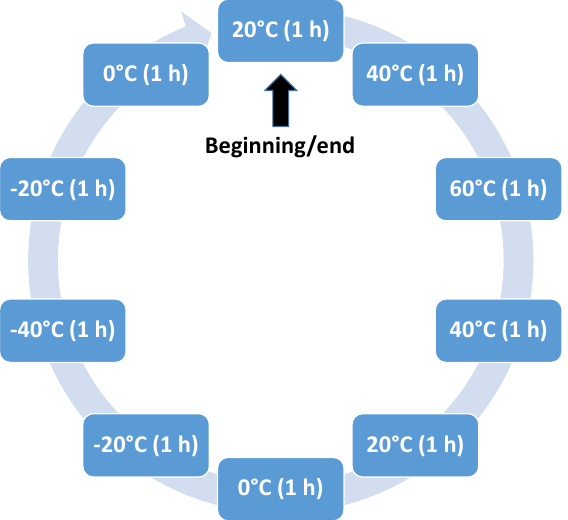
Figure 13. Description of the thermal cycle performed on TiO 2 –SiO 2 architectures between two extreme temperatures: 60 ◦ C and − 40 ◦ C. Each temperature level lasts 1 h, while a ramp of 1 ◦ C/min is applied between two consecutive values.